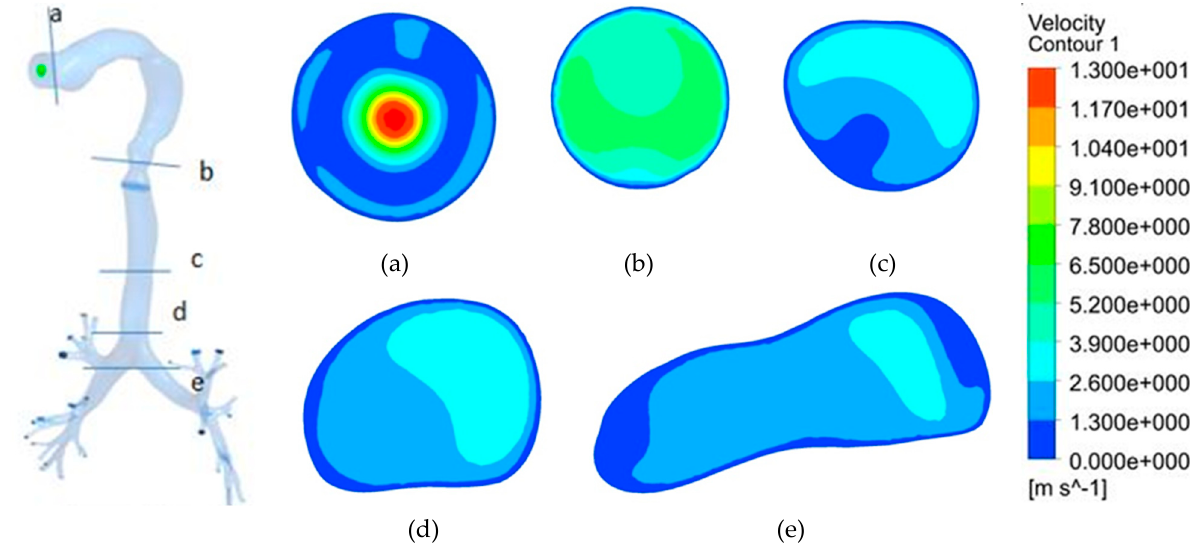
Figure 8. Velocity contour at transverse planes with constant fresh air inhalation. ( a ) At oral inlet; ( b ) At larynx; ( c ) At trachea; ( d ) Pre-bifurcation; ( e ) At first bifurcation.